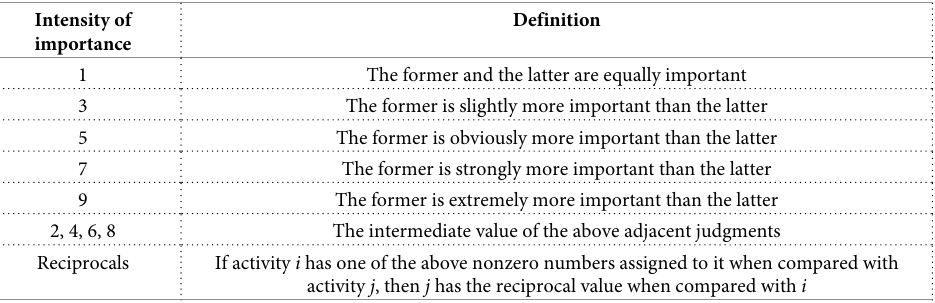
Table 4. The fundamental scale of absolute numbers